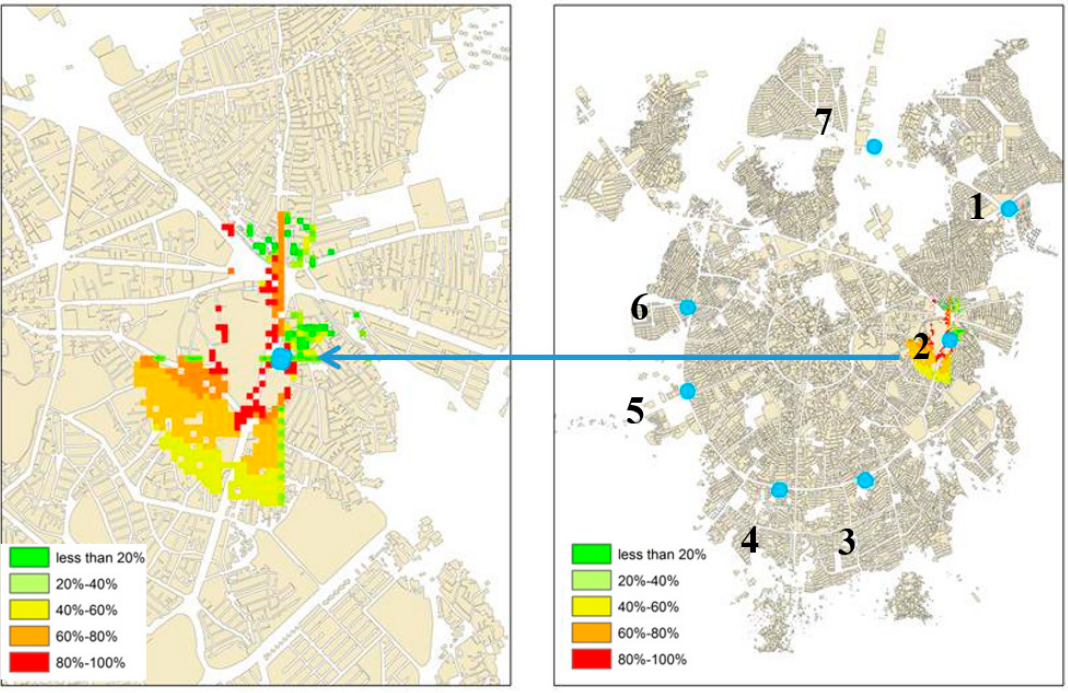
Figure 23. Visibility map of hypothetical tall building No. 2.